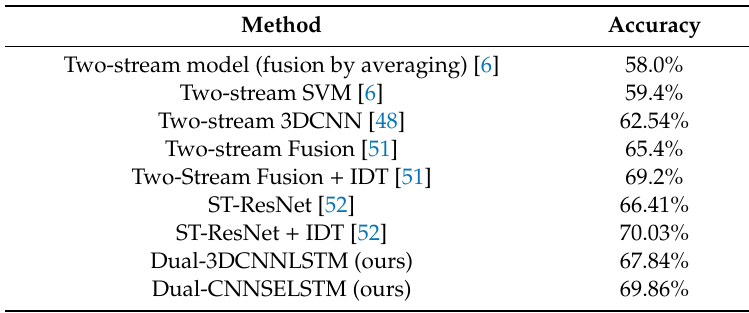
Table 2. Results comparison of HMDB51 dataset with our models and the state-of-the-art methods. Method